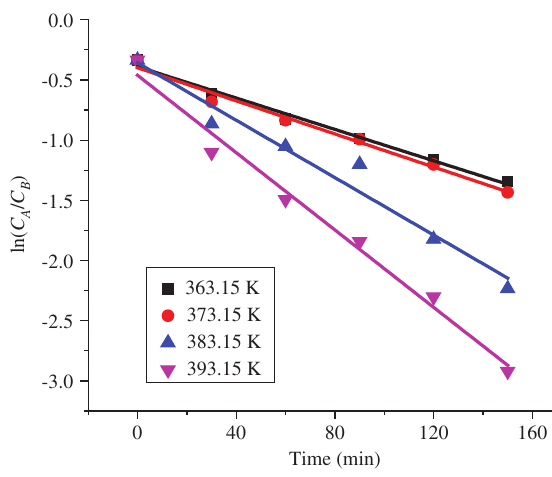
/ C ) versus time for esterification with butyric A B